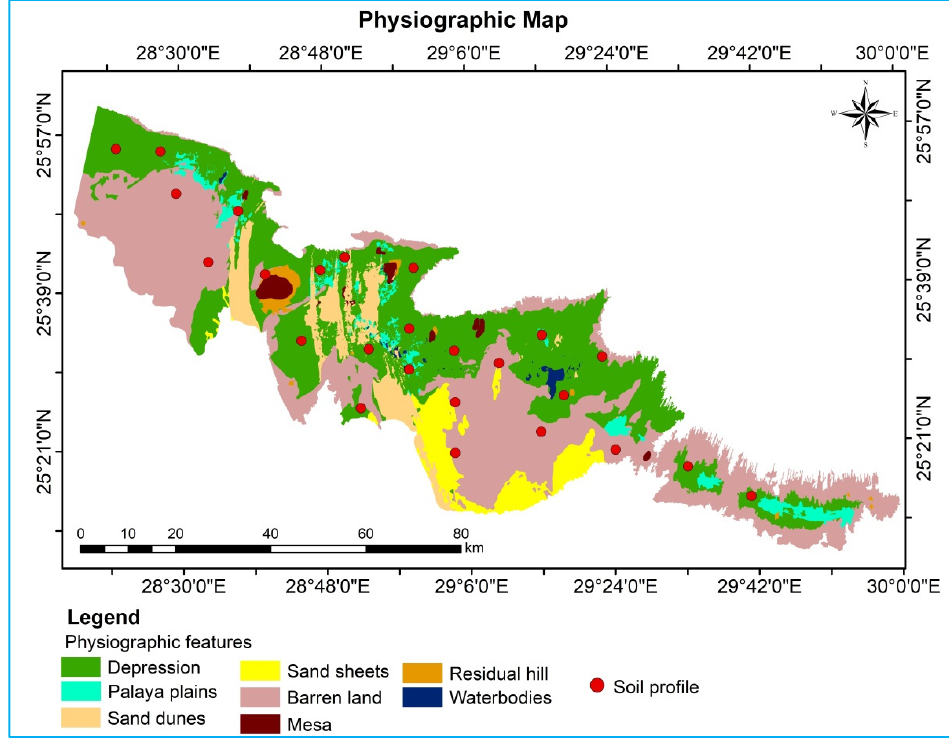
Figure 2. The physiographic map of the study area and sampling sites.